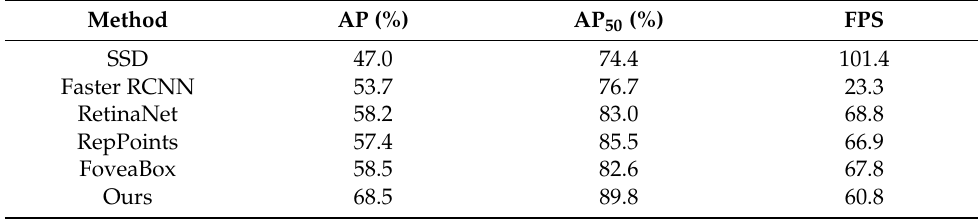
Table 2. The evaluation metrics of different methods on